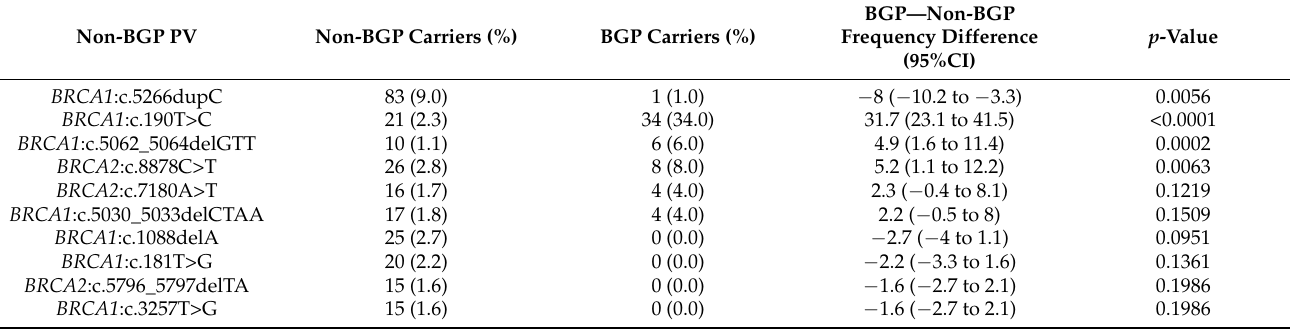
Table 2. The 10 most common non-BGP PVs and their frequency difference in the BGP and non-BGP